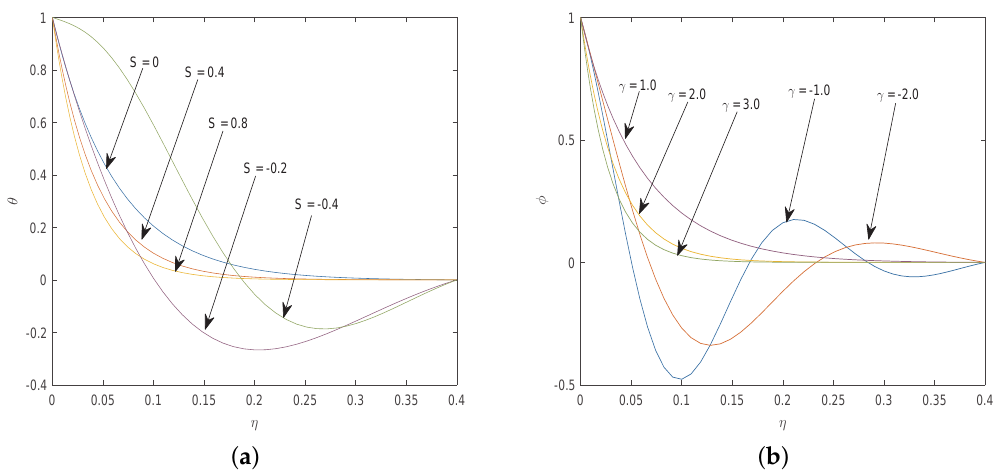
Figure 3. (a) Sensitivity analysis of θ with the variation of S and (b) Sensitivity analysis of φ with the variation of γ .